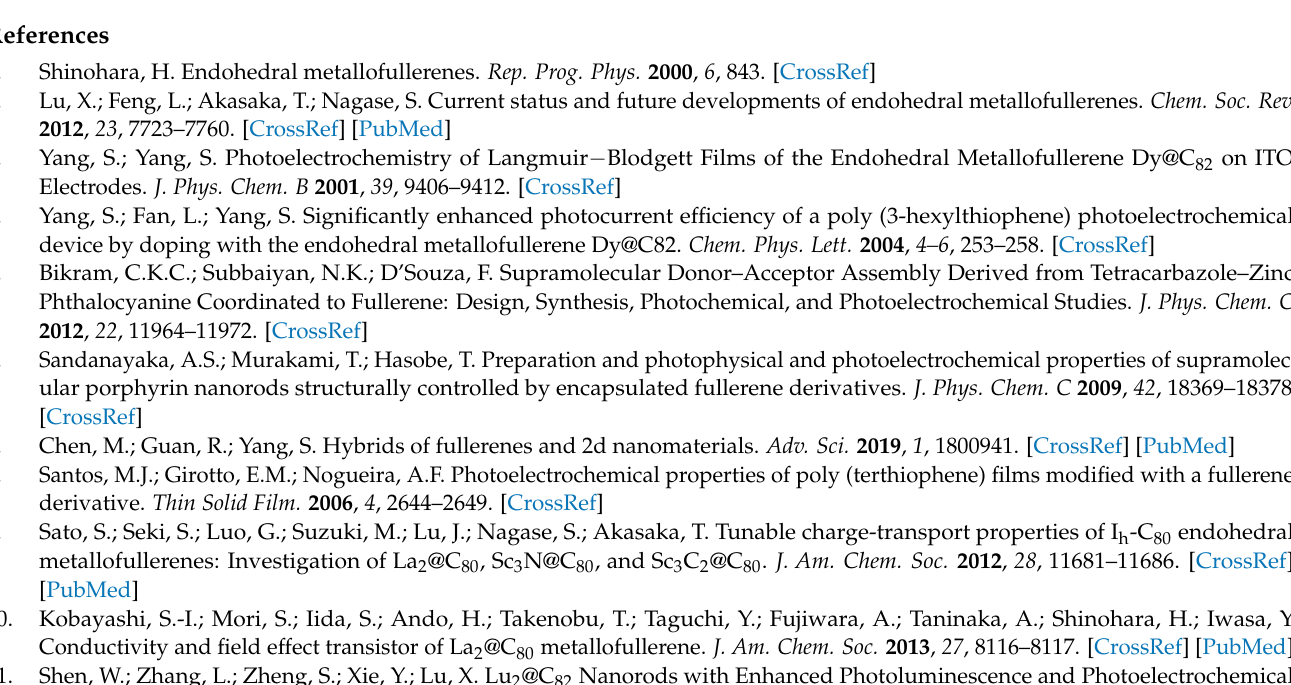
Figure S3: UV-vis-NIR absorption spectra of (a) Sc 3 N@C 78 , (b) Sc 3 N@C 80 , and (c) Sc 2 C 2 @C 82 , re- spectively. The insets show the enlarged spectra around onset wavelength, Figure S4: SEM image of Sc 2 C 2 @C 82 , Figure S5: Photocurrent response intensity of metallofullerenes, biphenyl, p − terphenyl, p − quaterphenyl, and [12]CPP on FTO glass, Figure S6: UV-Vis-NIR spectra of (a)Sc 3 N@C 78 , (b) Sc 3 N@C 80 , and (c) Sc 2 C 2 @C 82 with biphenyl, p − terphenyl, p − quaterphenyl, and [12]CPP, respectively, Table S1: The optimized energies of complex EMFs ⊂ [12]CPP, EMFs, and [12]CPP. Reference [31] is cited in